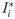
Infection localization and characteristics of endemic infection state.(Top) Localization within networks shown by endemic infection counts Ii* normalized by max(Ii*) for a given network. We use mutation rate μ = 10−3, transmission rate β = 25, waning immunity rate α = 1/50, and transcending immunity Δ = 4. (Middle) Infection localization regimes are revealed where normalized effective sample size is low (lattice and chain), occurring when few strains account for the majority of infections. (Bottom) endemic infections depend on not only transmission rate β, but also the breadth of cross-protective effects determined by transcendence rate Δ. Fixed parameters are n = 25, μ = 10−3, α = 1/50.